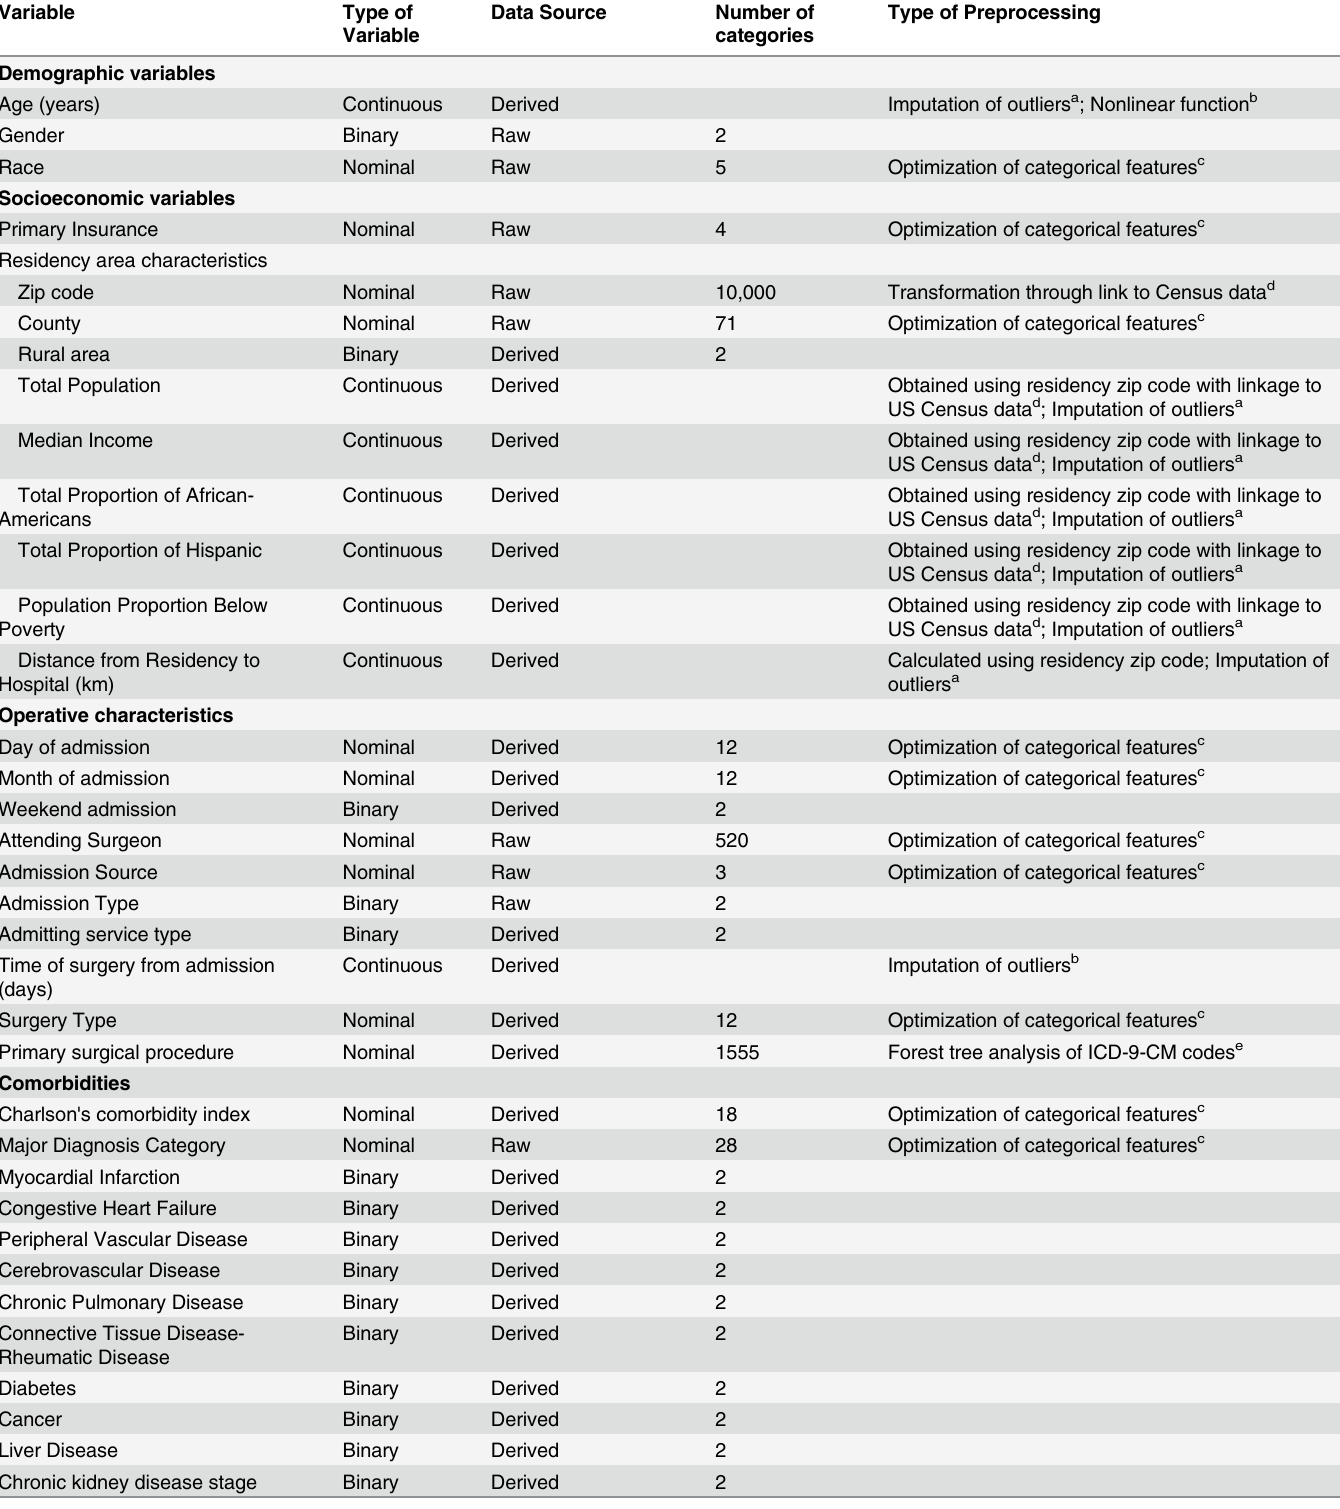
Table 1. Characteristics of input